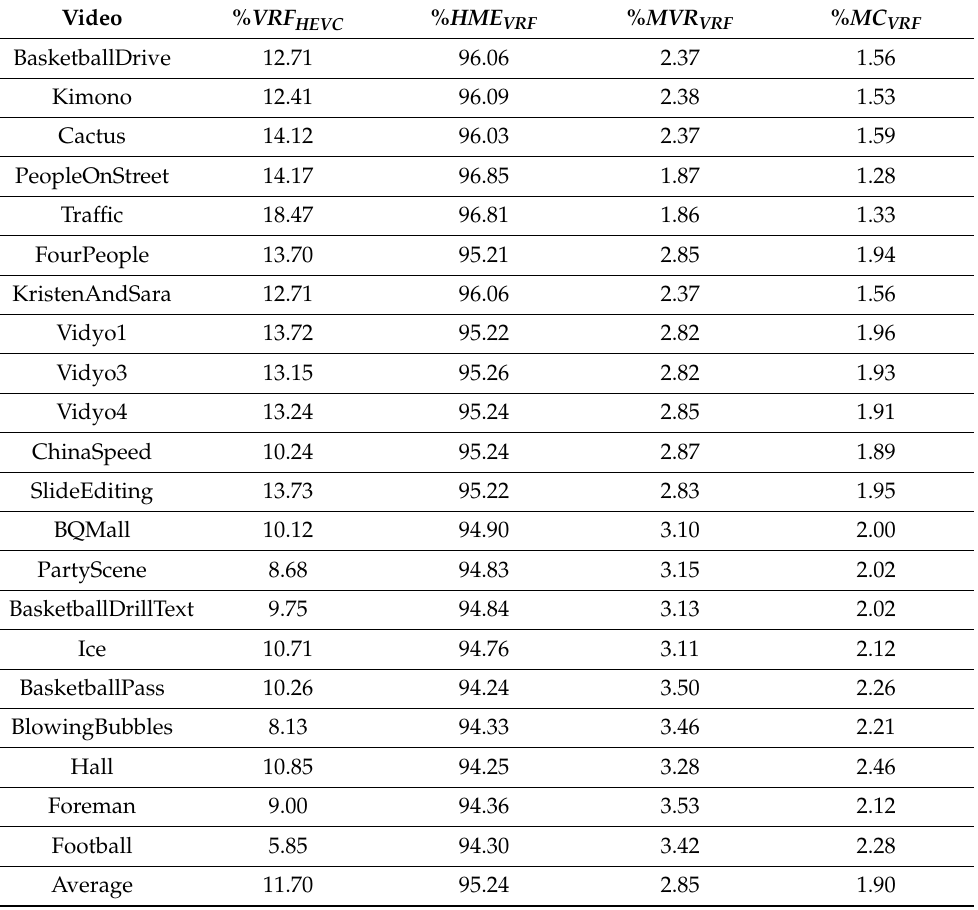
Table 8. VRF Complexity